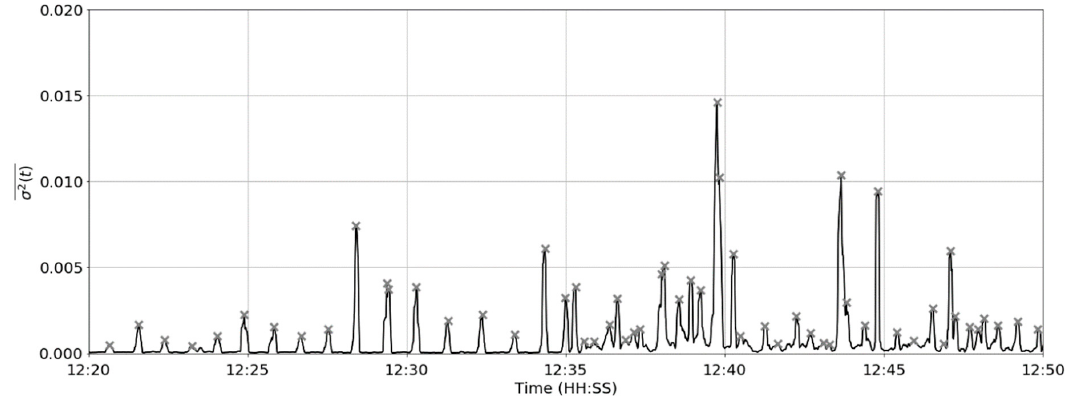
Figure 9. The peak detection with a prominence value of 0.00027.